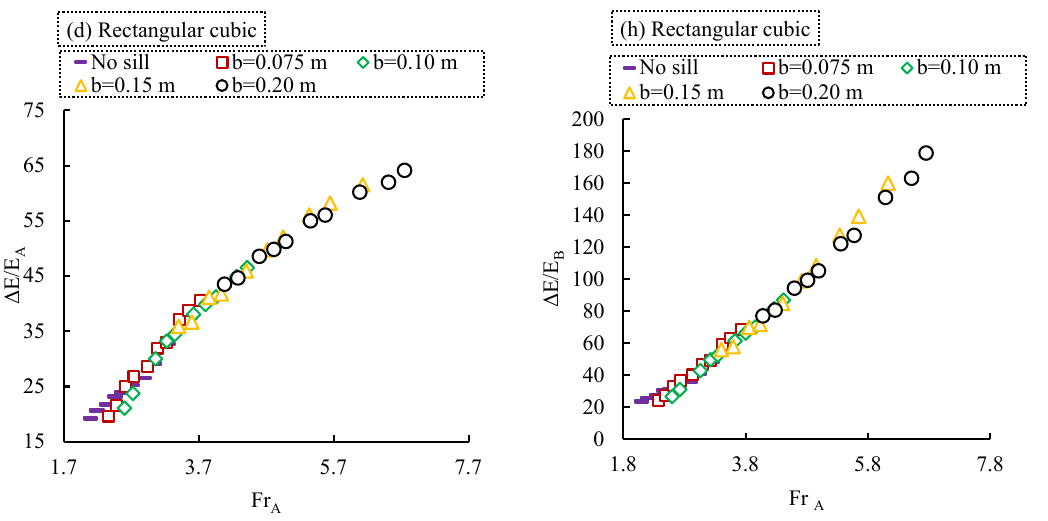
Figure 7. Relative energy loss for the ( a–d ) upstream and ( e–h ) downstream sections of the jump with sill.